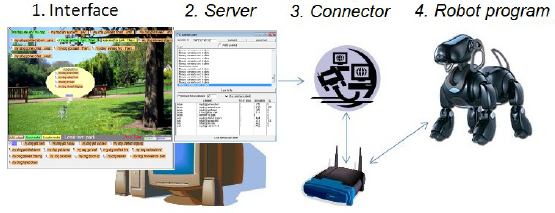
Figure 1. System architecture of